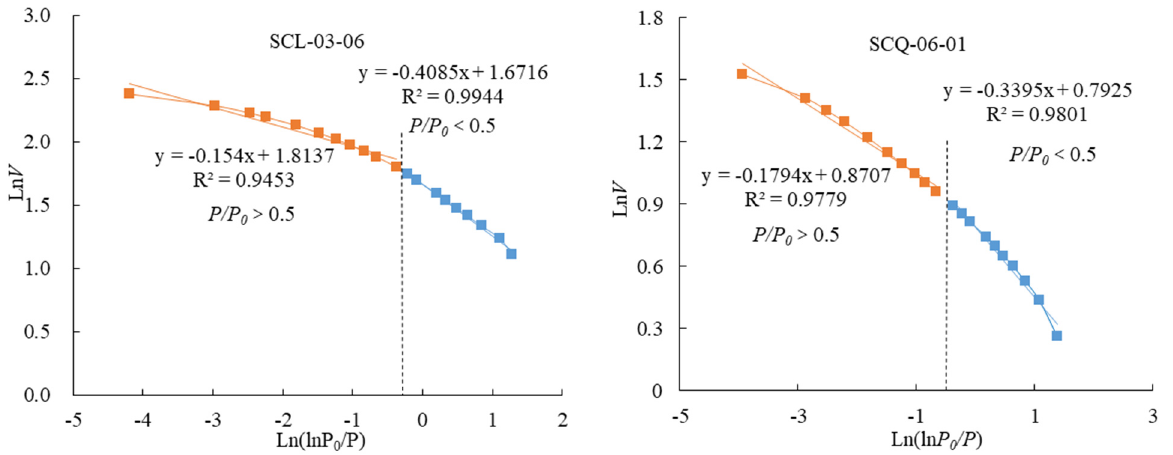
Figure 11. Plots of ln( V ) vs. ln(ln( P 0 / P )) for typical shale samples based on the data from N 2 adsorption experiments.